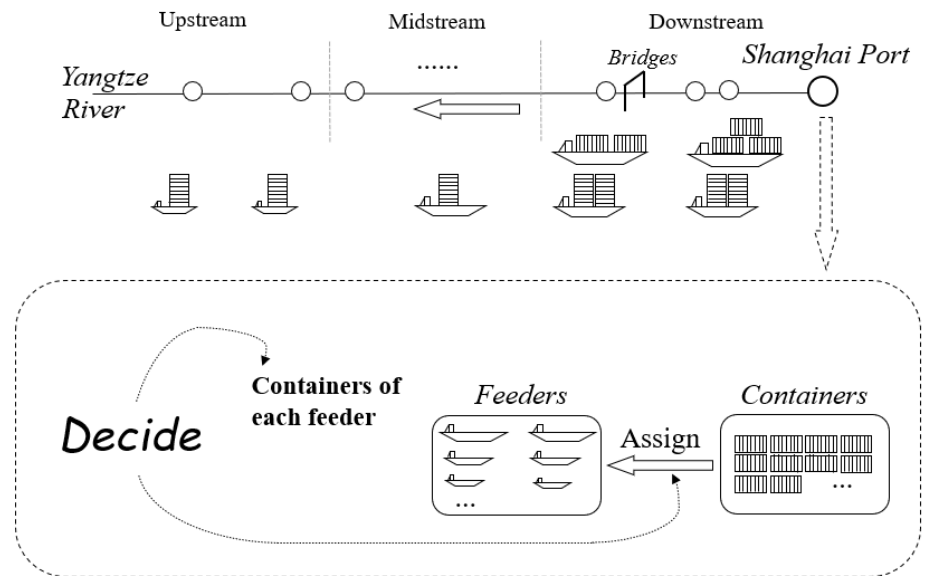
Figure 2. Feeder scheduling and container transportation along the Yangtze River.